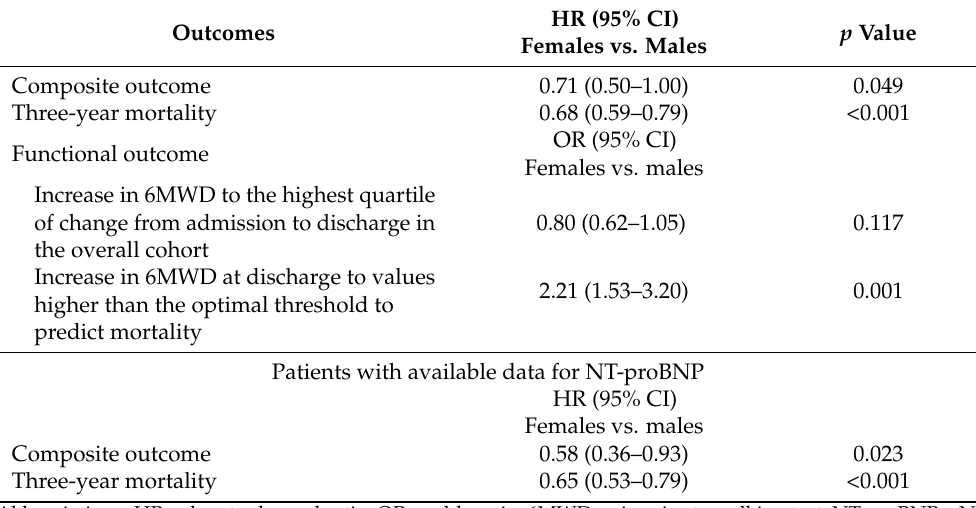
Table 2. Results of multivariable